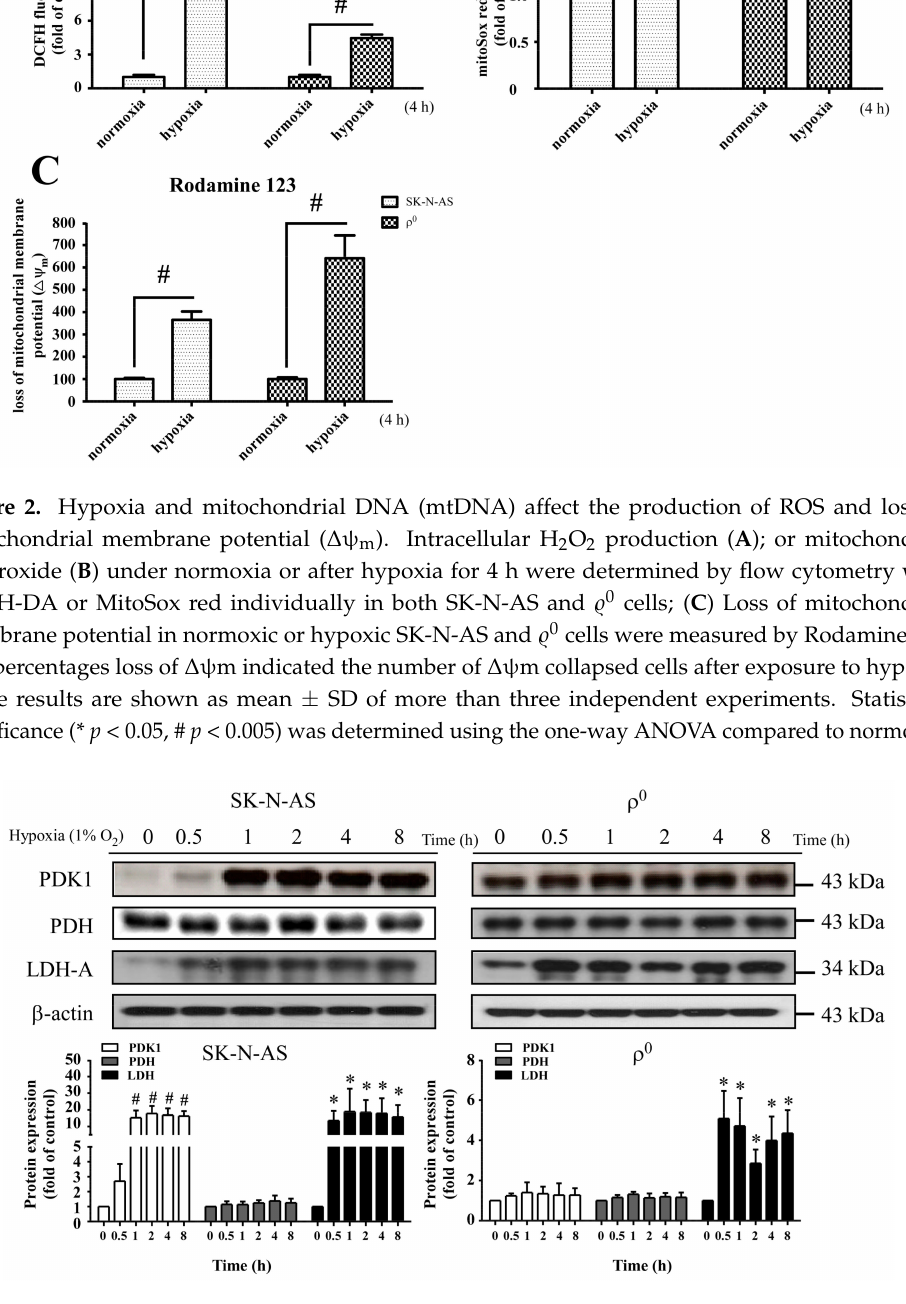
Figure 3. Effect of hypoxia on metabolism-related proteins in SK-N-AS and 2137 (cid:36) 0 cells. Upper panel shows immunoblotting of the expression of pyruvate dehydrogenase kinase 1 (PDK1), pyruvate dehydrogenase (PDH) and lactate dehydrogenase A (LDH-A) proteins after different hypoxic times; the bar chart in lower panel shows the relative changes (to β -actin) of PDK1, PDH and LDH-A proteins. The results are shown as mean ± SD of more than three separate experiments in which similar results were obtained. * Represented p < 0.05 and # represented p < 0.005 when compared to normoxic condition were determined using the one-way